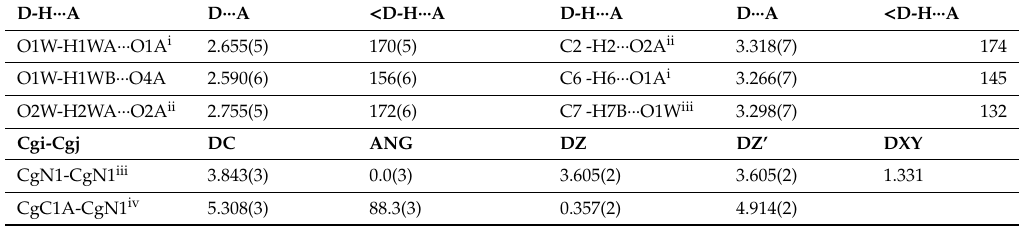
DC ANG DZ DZ’ DXY